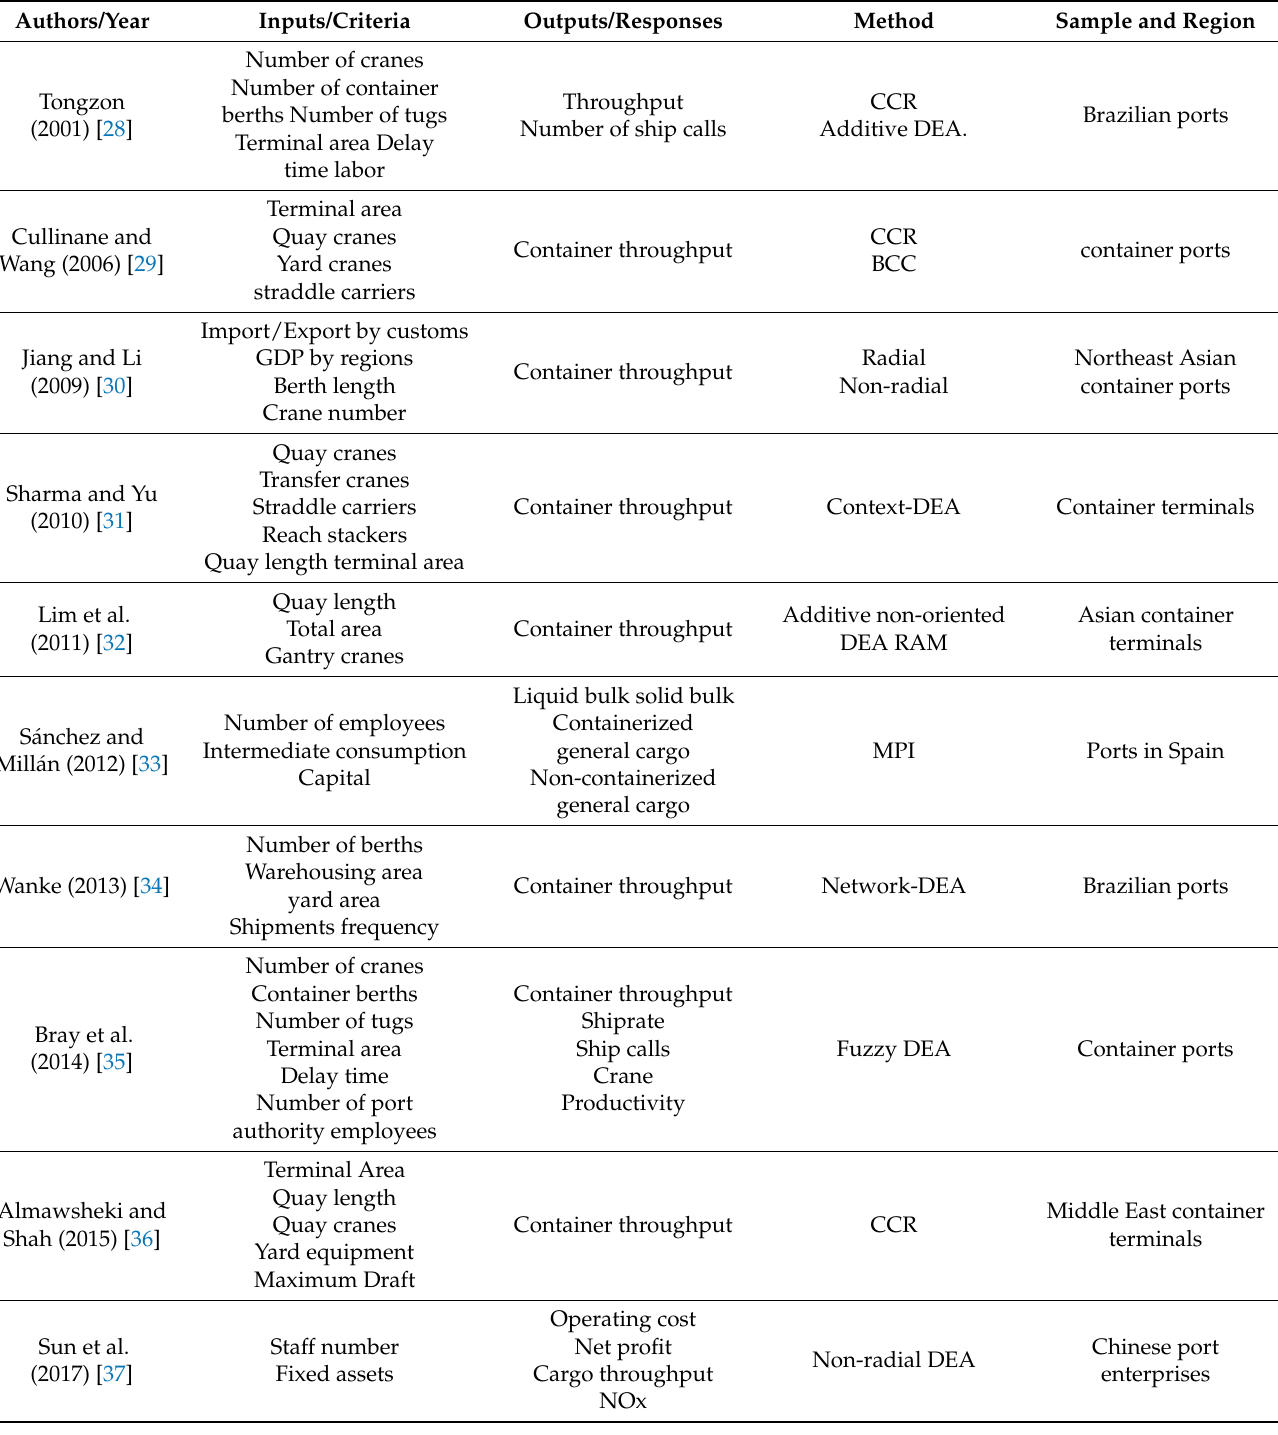
Table 1. A summary of previous study methodologies and problem